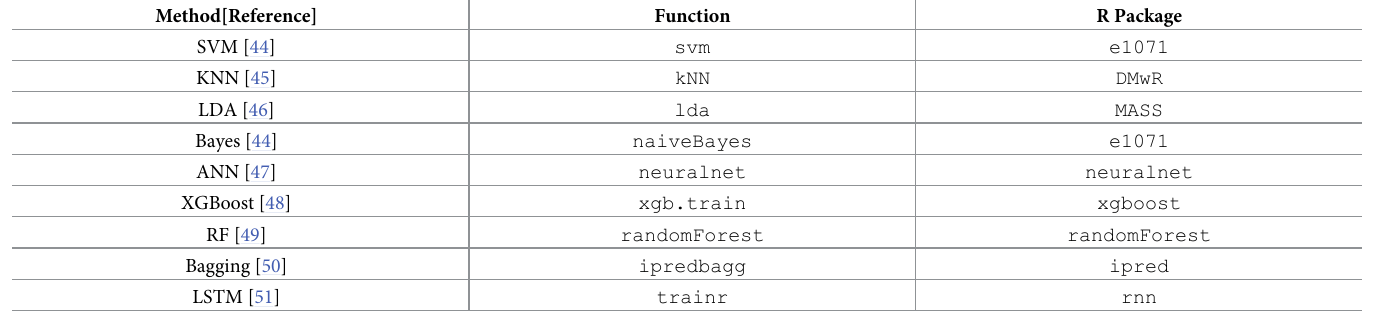
Table 6. A list of existing methods and corresponding packages.